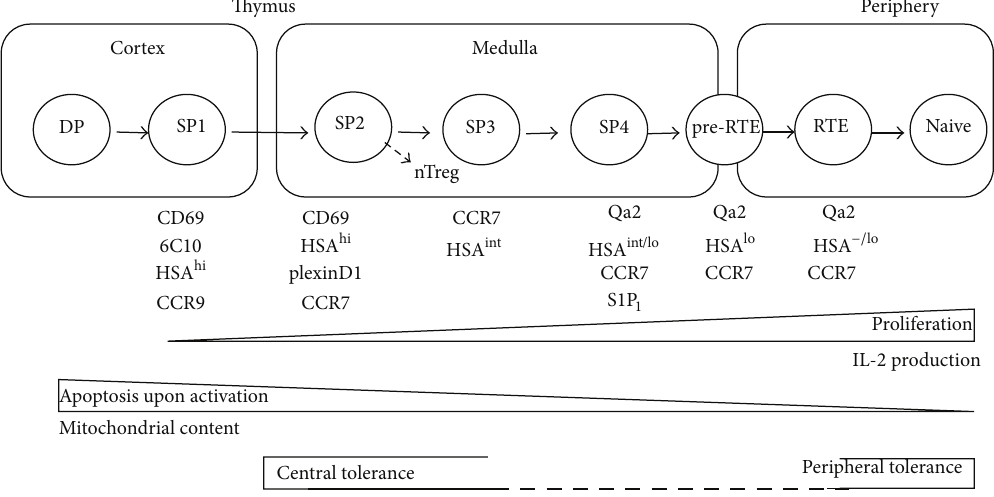
Figure 1: A schematic illustration of the development and migration of CD4 single-positive thymocytes and CD4 + recent thymic emigrants. DP: double-positive; SP, single positive; RTE: recent thymic emigrants; pre-RTE: thymus-leaving RTE